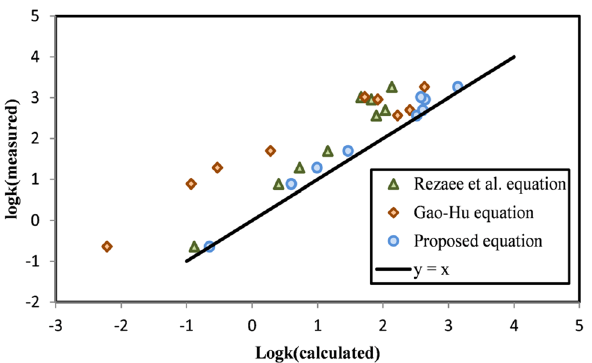
Fig. 10 Cross-plot of the measured and the calculated permeabilities for the proposed, Rezaee et al., and Gao and Hu equations (sandstone samples)